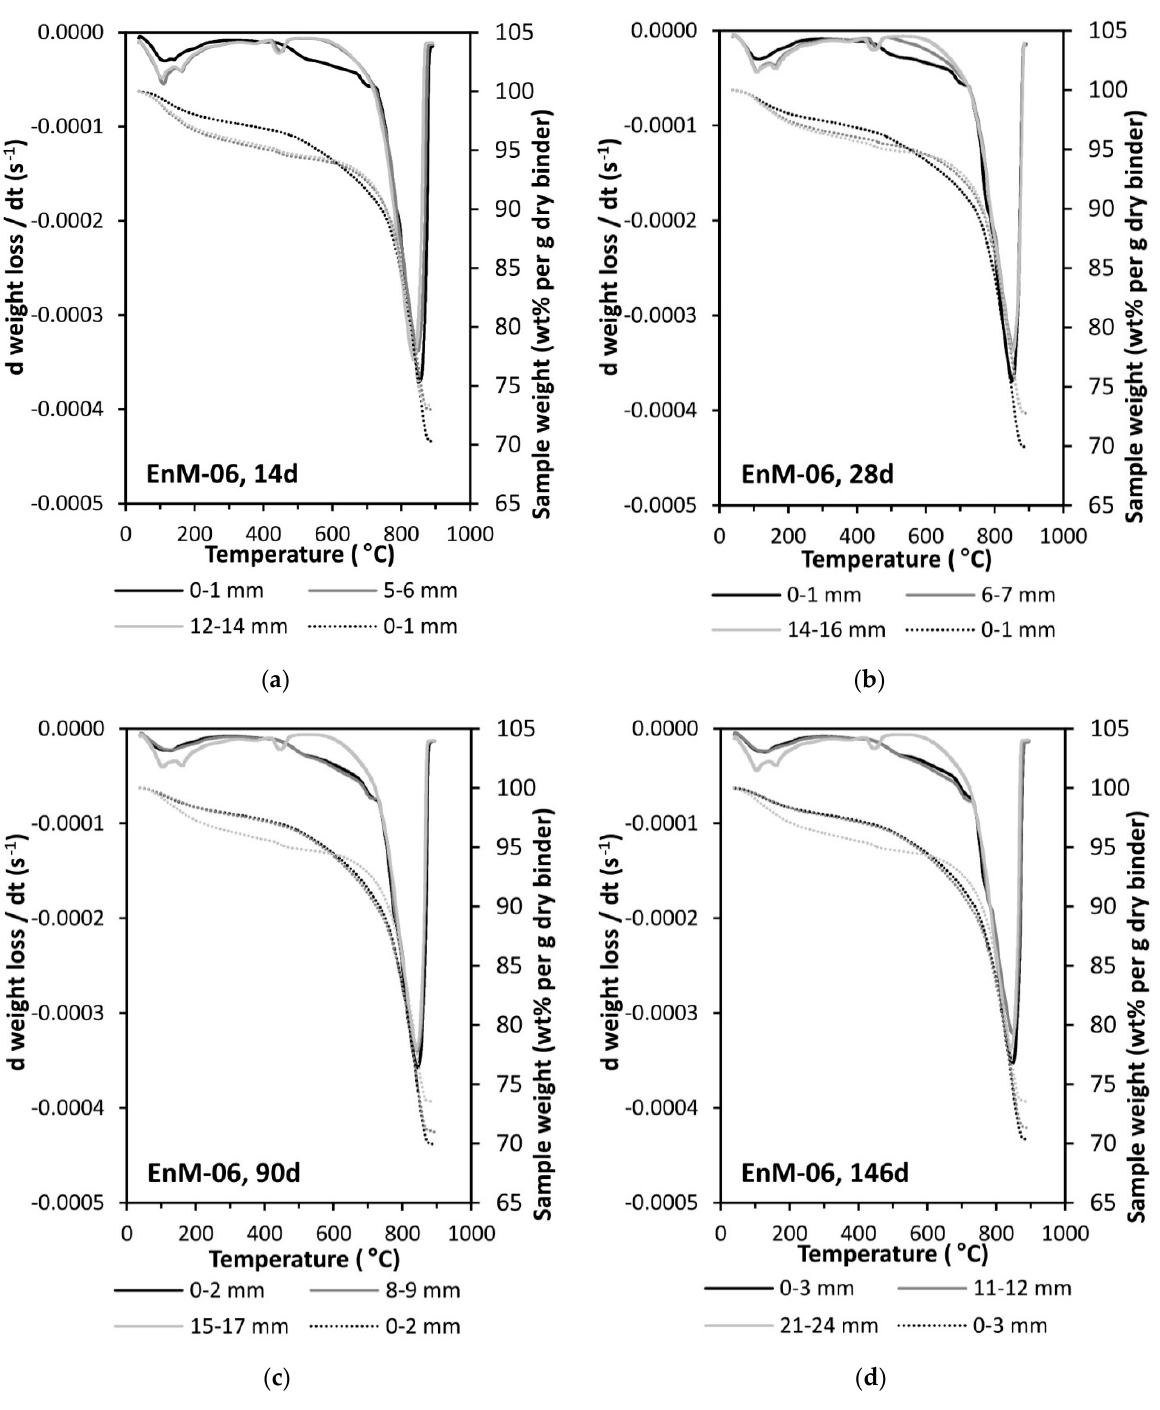
Figure A1. Differential thermal analysis (DTG) results obtained on EnDurCrete mortar, EnM-06, after ( a ) 14, ( b ) 28, ( c ) 90, and ( d ) 146 days of exposure to accelerated carbonation. Extension “-06” refers to the water-cement ratio of 0.6. Each graph shows the results of the top layer in black, the innermost layer in light grey, and one layer in between, in medium grey.